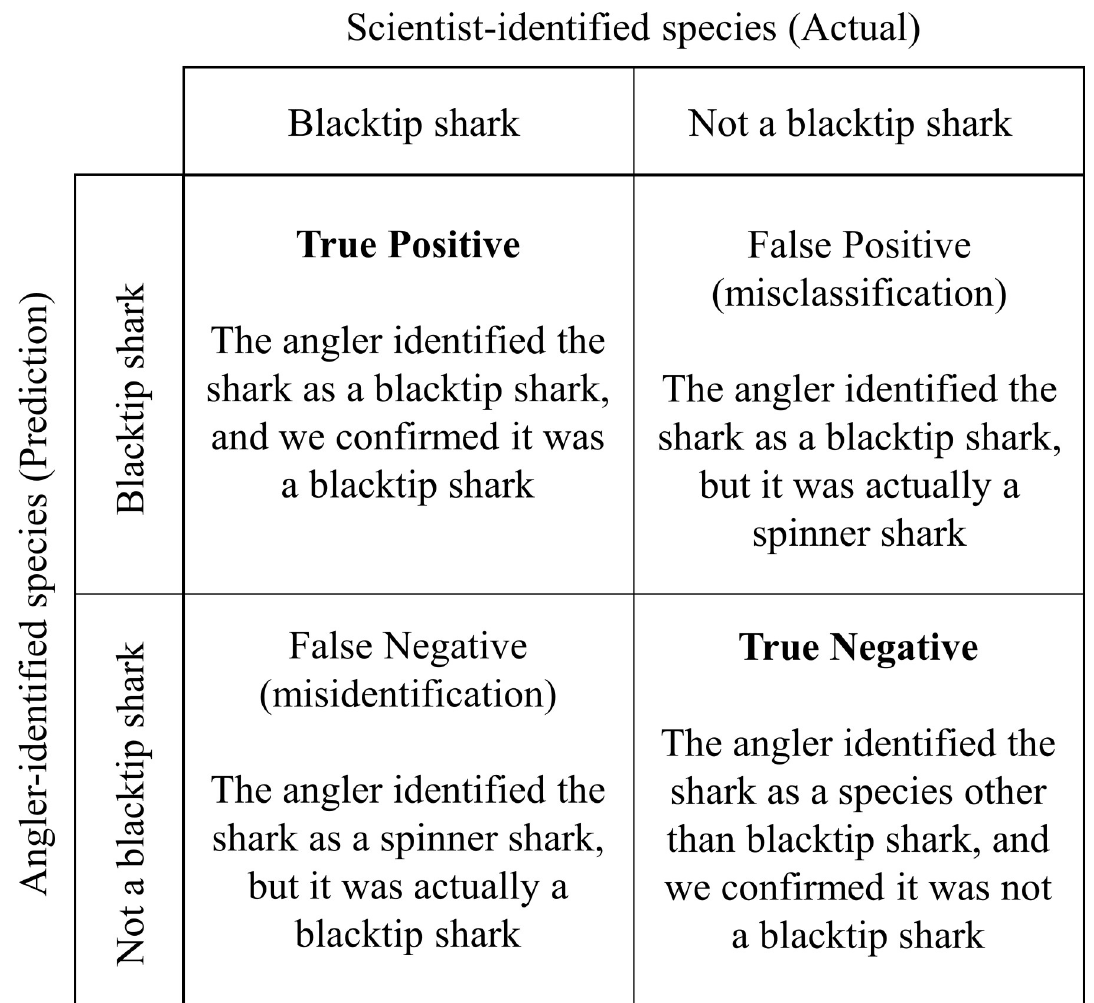
Fig 2. Example confusion matrix for binary classification of blacktip sharks. An example for each correct (true positive; true negative) and incorrect (false negative; false positive) outcome is given within each cell.